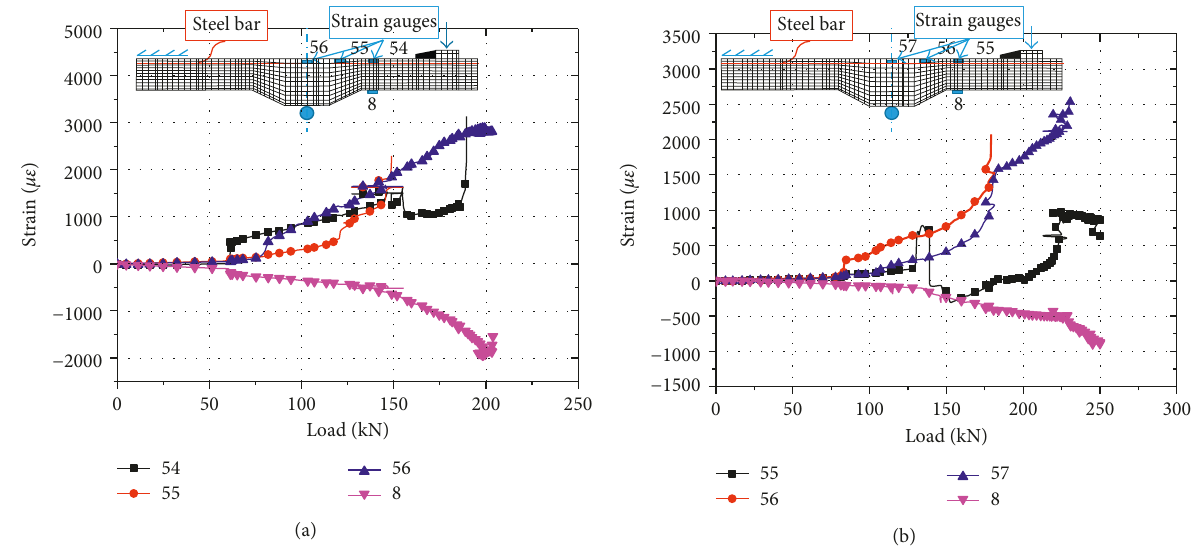
Figure 24: Strain results of N1 and N2 specimens under different loads. (a) N1. (b)